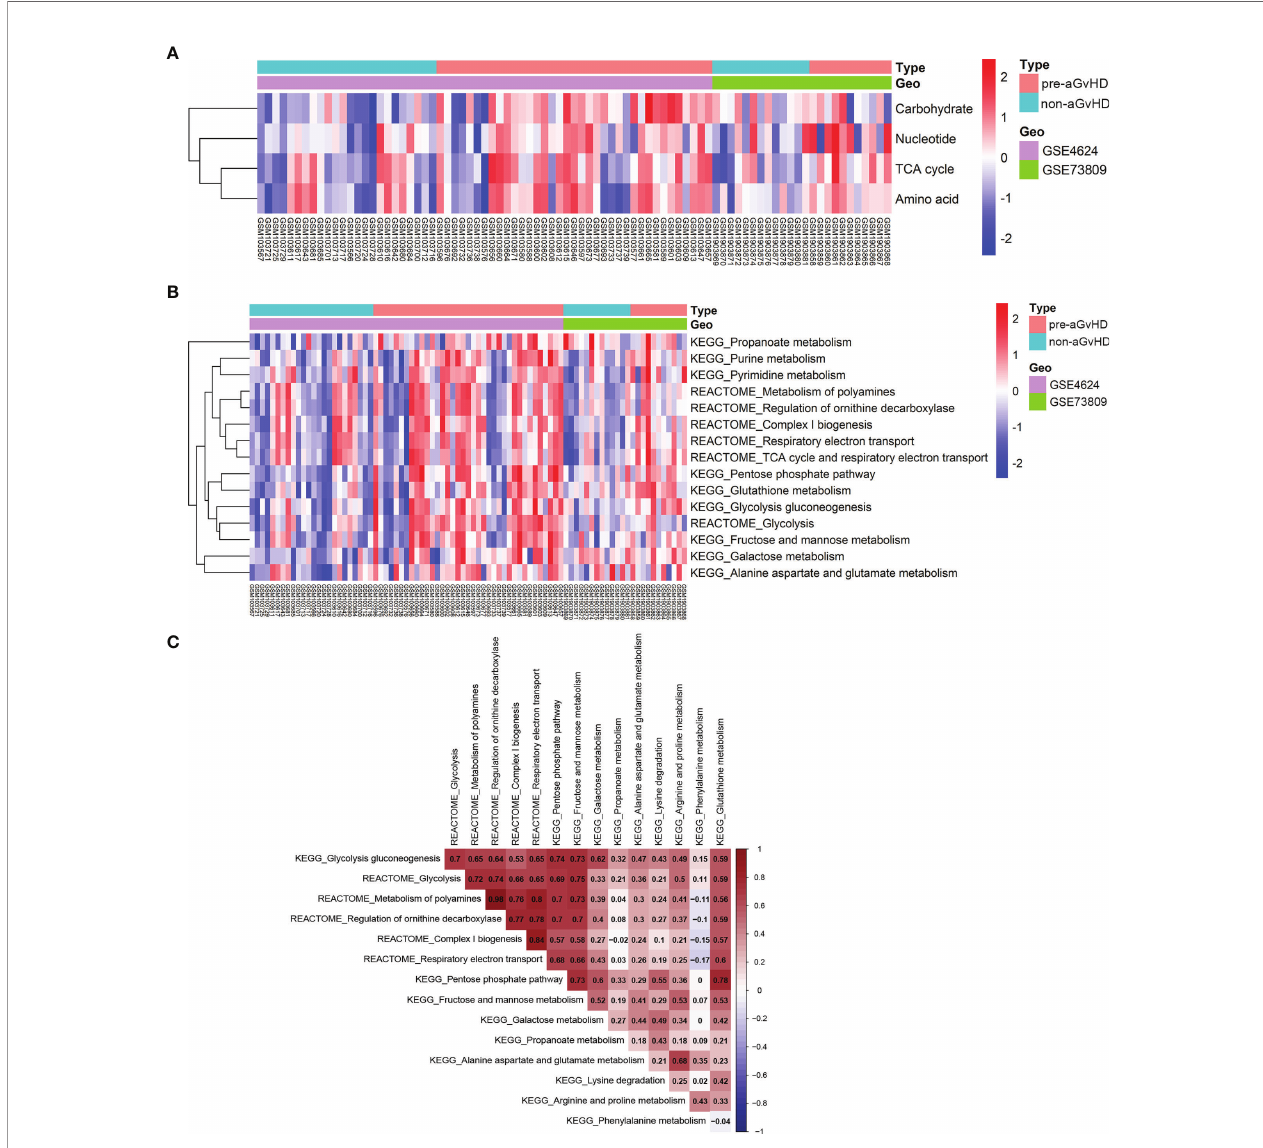
FIGURE 1 | Distinct metabolic reprogramming based on pathway gene expression. (A) Heatmap shows enrichment of four super-metabolic signatures across each sample. The right longitudinal axis indicates the names of metabolic signatures. The left longitudinal axis represents clustering of metabolic signatures. Red denotes high activity and blue denotes low activity of metabolic pathways. Differentially enriched pathways with P < 0.05 and |log FC| >1 were considered signi fi cant. The terms indicated are as follows: Carbohydrate, carbohydrate signature; Nucleotide, nucleotide signature; TCA cycle, tricarboxylic acid (TCA) cycle signature; Amino acid, amino acid signature; pre-acute graft-versus-host disease (aGvHD), T-cell samples from patients who further developed acute graft-versus-host disease; non-aGvHD, T-cell samples from patients without graft-versus-host disease. (B) Heatmap shows different activities of metabolic sub-pathways derived from carbohydrate, nucleotide, TCA cycle, and amino acid signatures between pre-aGvHD and non-aGvHD samples. (C) Correlations of metabolic sub-pathway activities with each other. Color indicates the correlation direction. Each cell contains Pearson correlation coef fi